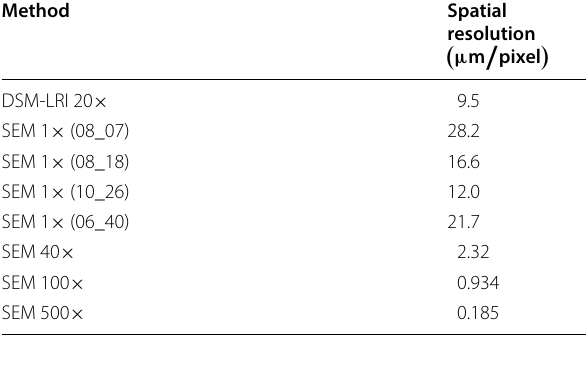
Table 1 Spatial resolution of DSM-LaRI and SEM Method Spatial